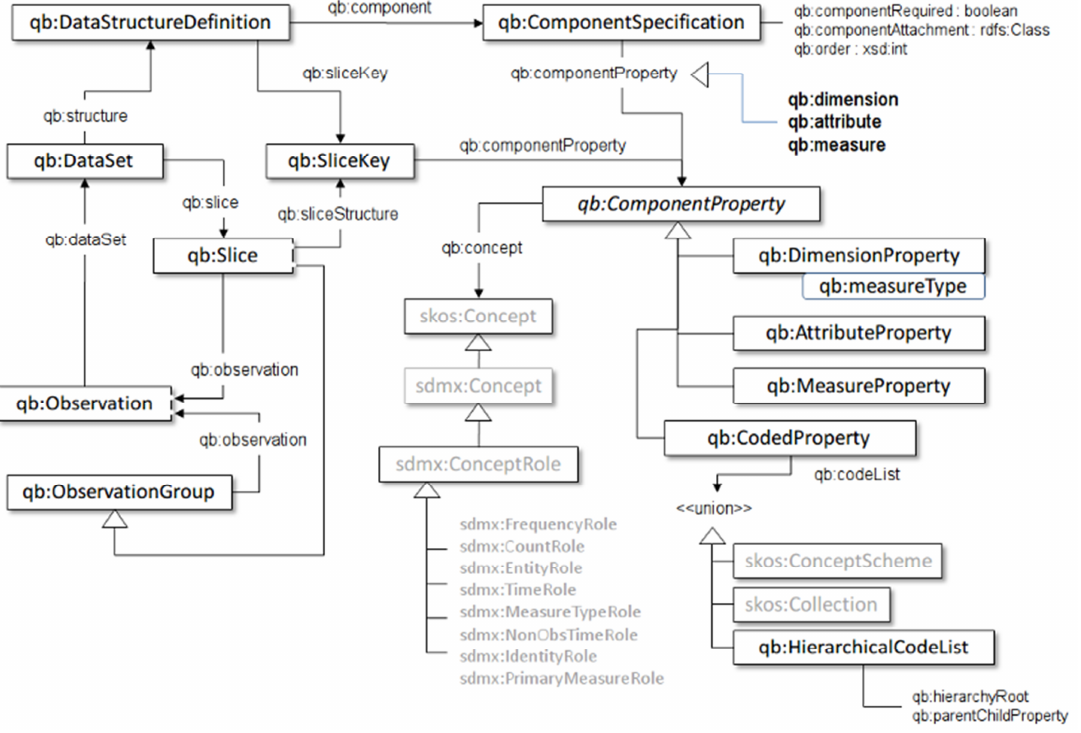
Figure 9: The W3C RDF qb